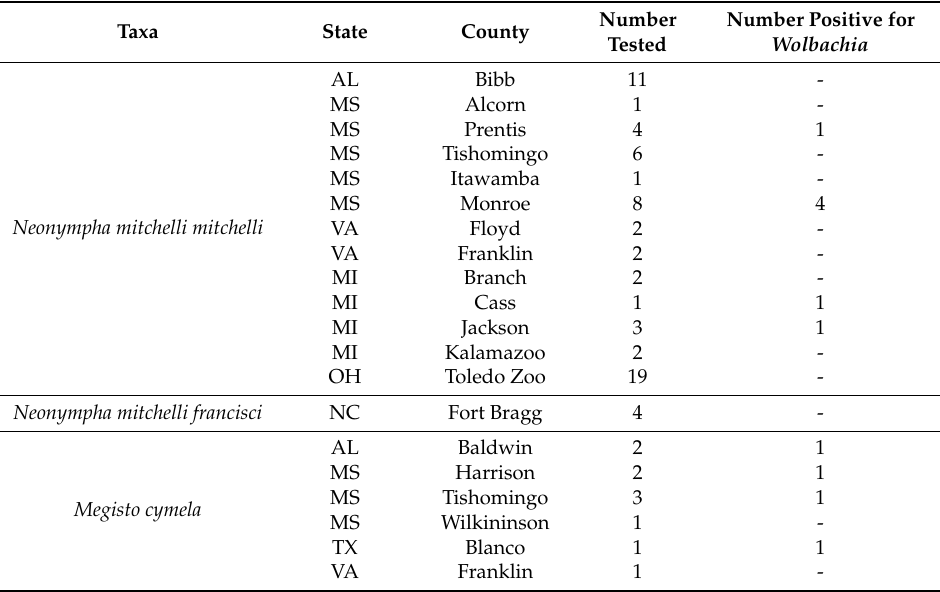
Table 1. Wolbachia presence in N. mitchelli